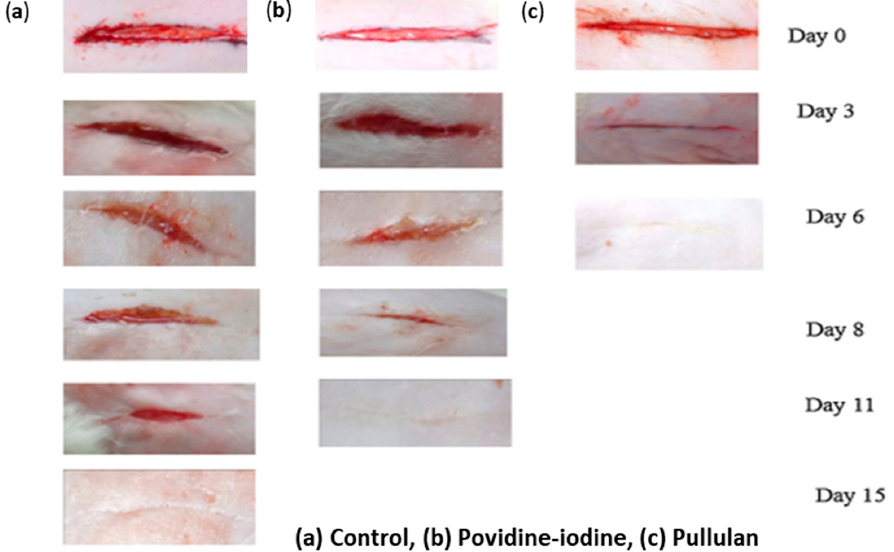
Figure 7. Wound healing rate in sutureless wounds in rats. Reproduced from [84], with permission Figure 7. Shows the wound healing rate in sutureless wounds in rats. Reproduced from the article from Elsevier, [84], with permission from Elsevier, 2022.